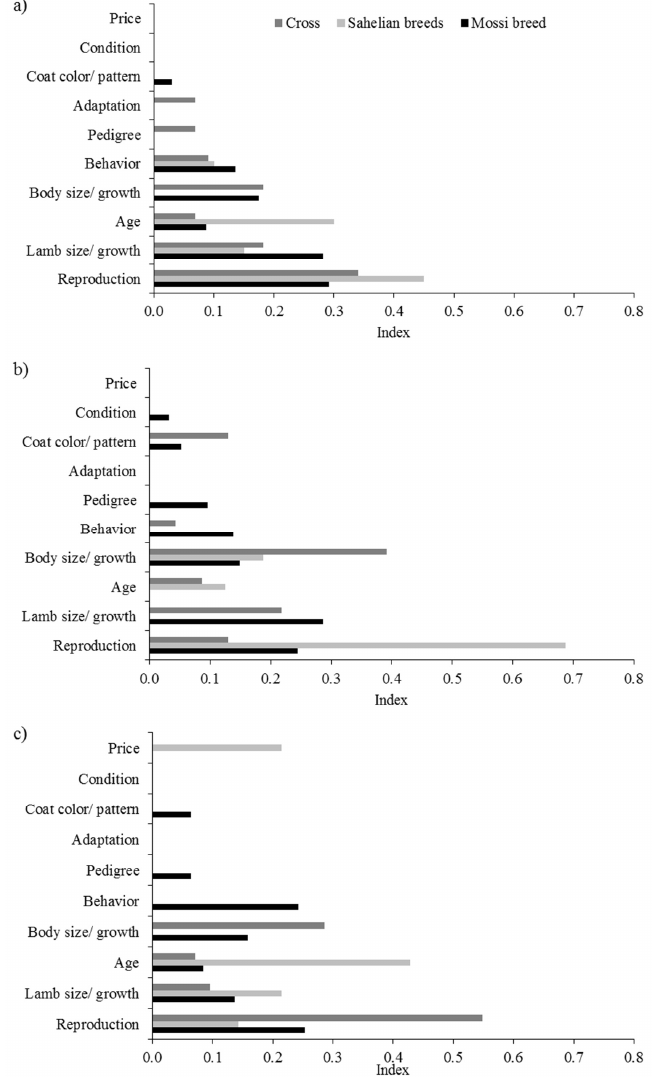
Figure 5. Relative importance (weighted index) of reasons for ranking individual ewes as best ( a ), average ( b ) and poor ( c ) within breeds. A maximum of three reasons, where the most important reason was weighted by 3, the second most important reason by 2 and the third most important reason by 1.